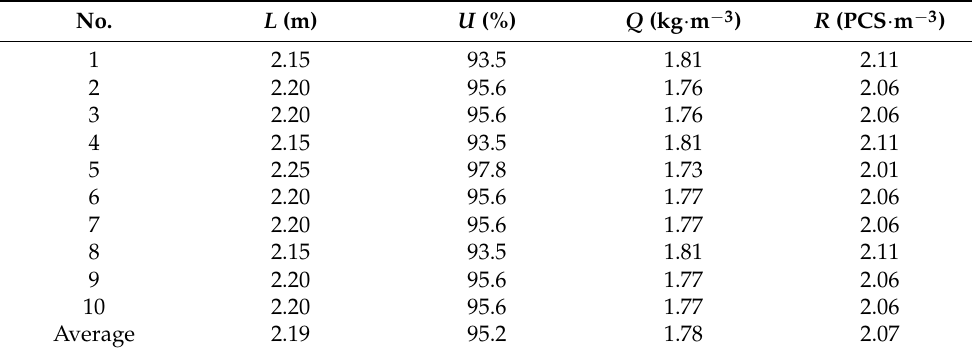
Figure 11. Blasting hole layout of the optimized scheme (unit: mm). Table 8. Statistical data of the final blasting results for the optimized